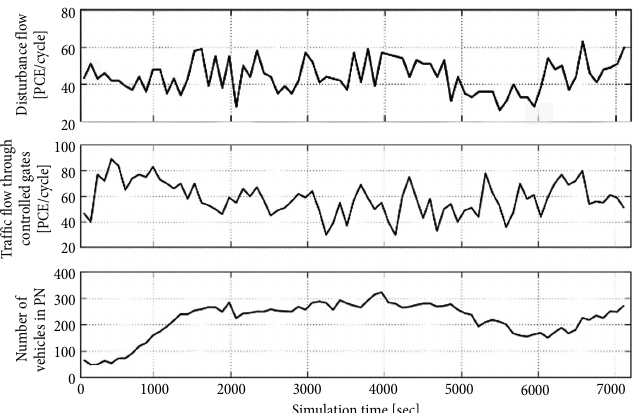
Fig. 5. Scenario 1: gate inputs and number of vehicles in PN